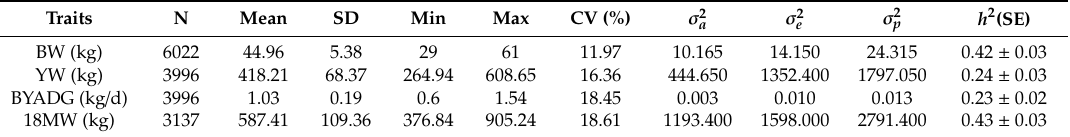
Table 1. Descriptive statistics and variance components of growth traits in Chinese Simmental beef cattle a .